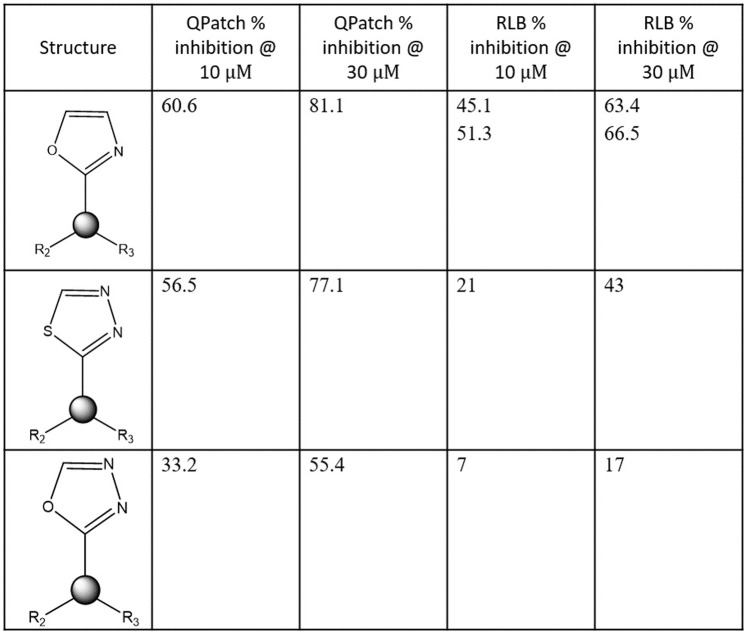
Representative activity cliffs for the proprietary hERG blocker series 2 (see text) comprised of R1 (corresponding to BP) and R2/R3 (corresponding to BC).The data suggests that hERG occupancy is disrupted by the projection of a highly polar group (oxadiazole) versus a less polar group (sulfadiazole or oxapyrrole) into the putative localized region of H-bond depleted solvation at site Y.